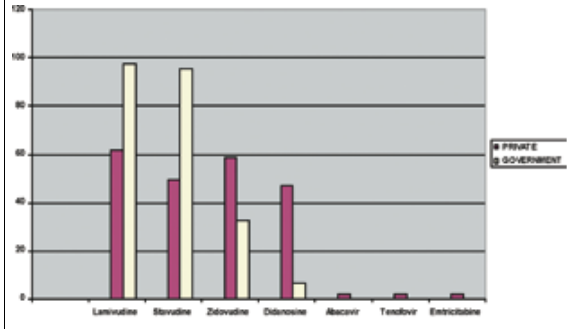
Fig. 1. Nucleoside reverse transcriptase inhibitor use by patients in the private sector (%) compared with combined use by all patients in the government programme (%).